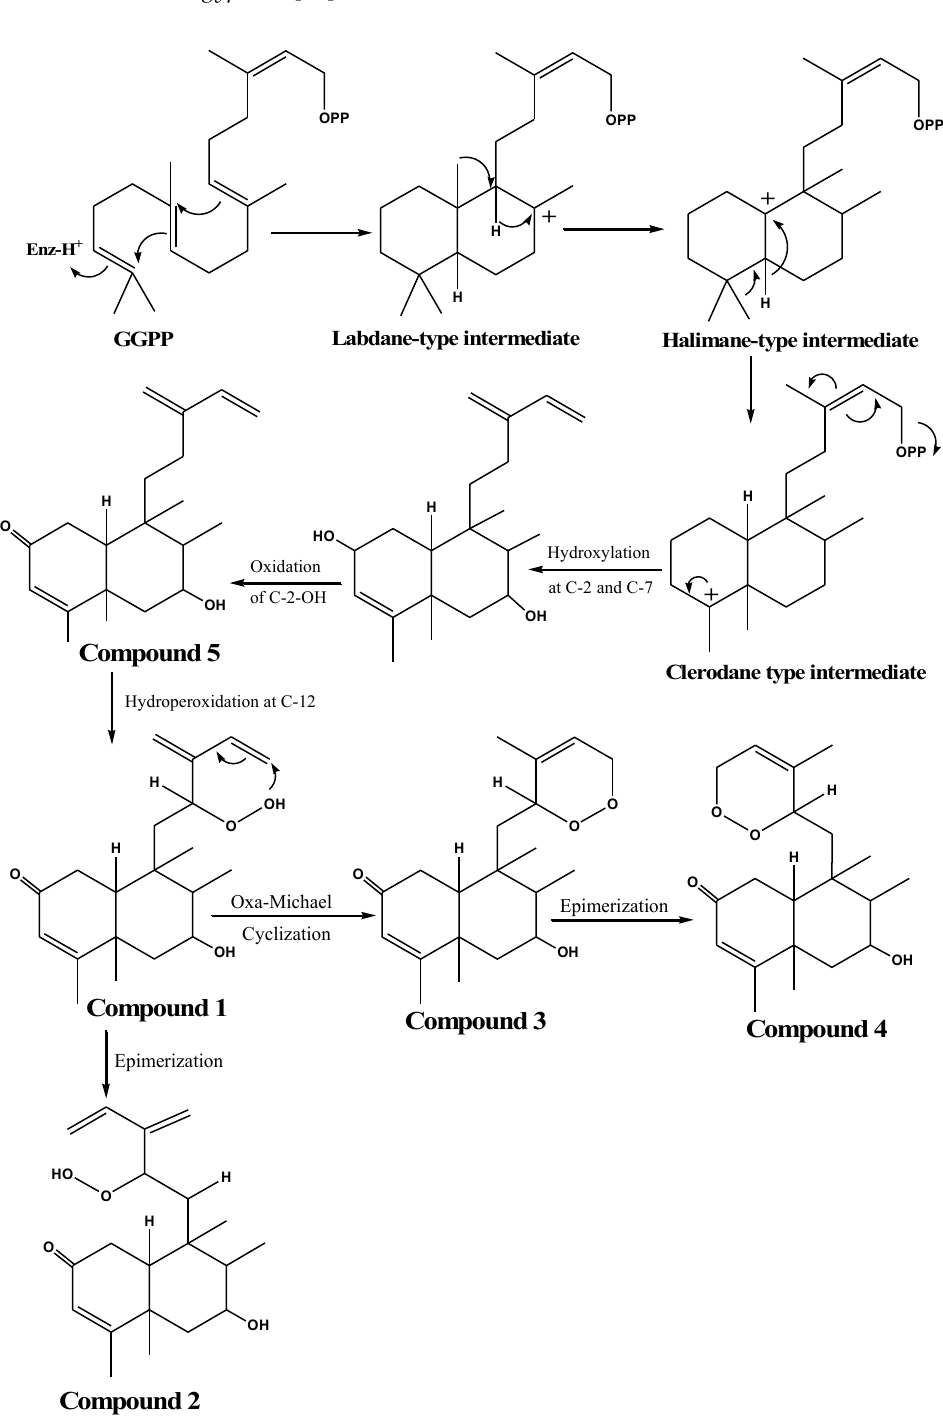
Figure 4. Proposed scheme for the biosynthesis pathway of the isolated metabolites ( 1 – 5 ).